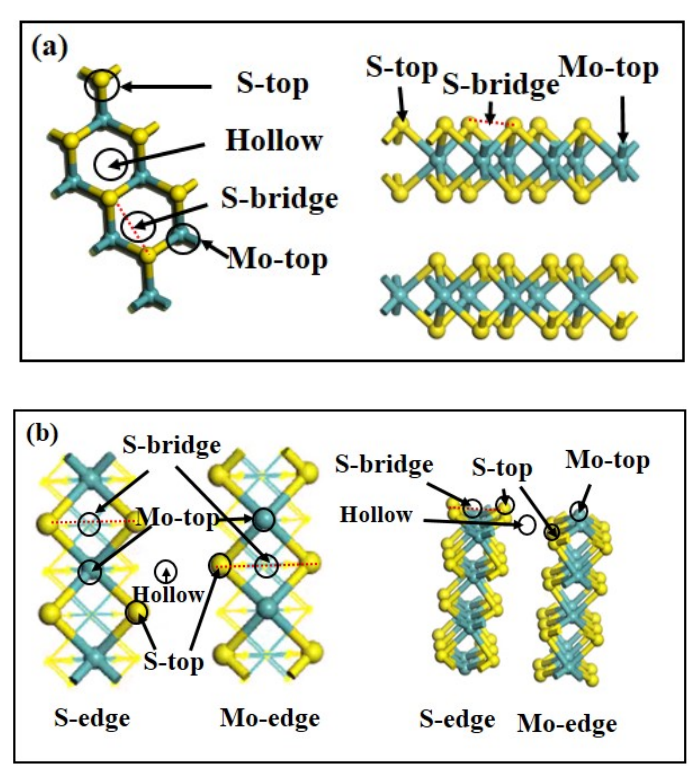
Figure 9. Adsorption sites on ( a ) molybdenite (001) surface and (b ) molybdenite (100) surface.